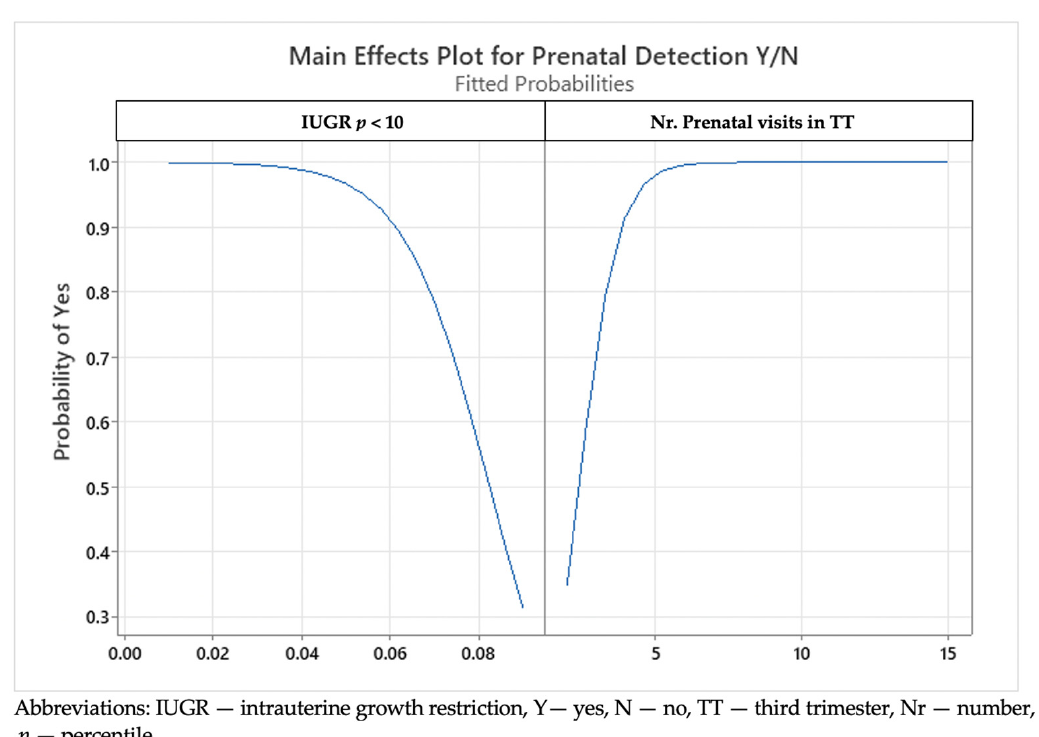
Figure 1. A main effect plot showing interactions between the prenatal detection, the estimated fetal weight percentile, and number of prenatal visits in the third trimester.